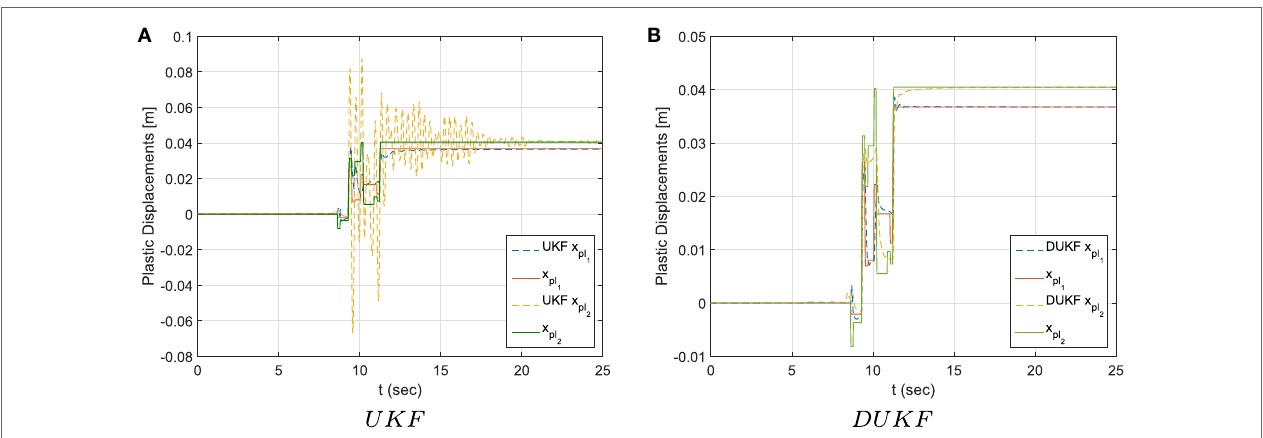
FIGURE 15 | Estimated over real values for the parameters, for the disadvantageous for the DUKF scenario of initial estimates F y = 60. F y 2